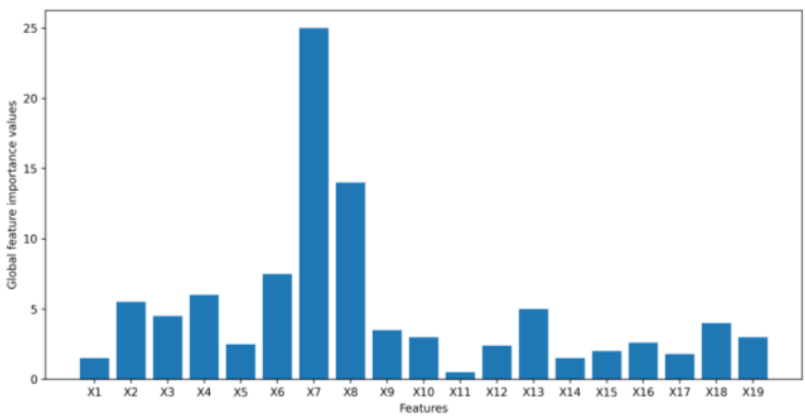
Figure 12. Global feature importance values for dataset 2.